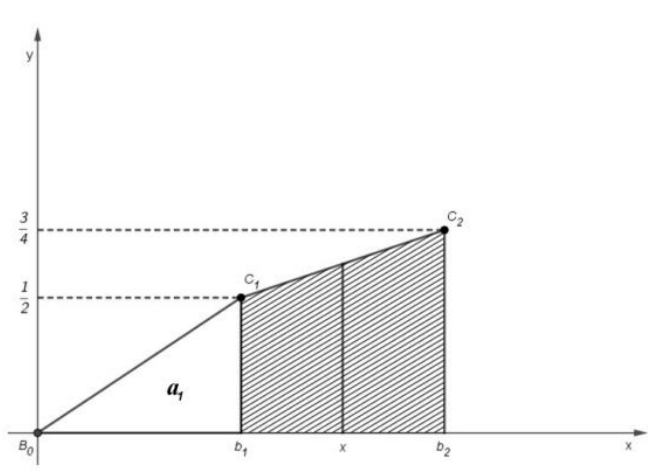
Figure 4. T he area of the trapezoid defined by points 𝐵 0 , 𝐶 1 , 𝑋 1 , 𝑋 2 .